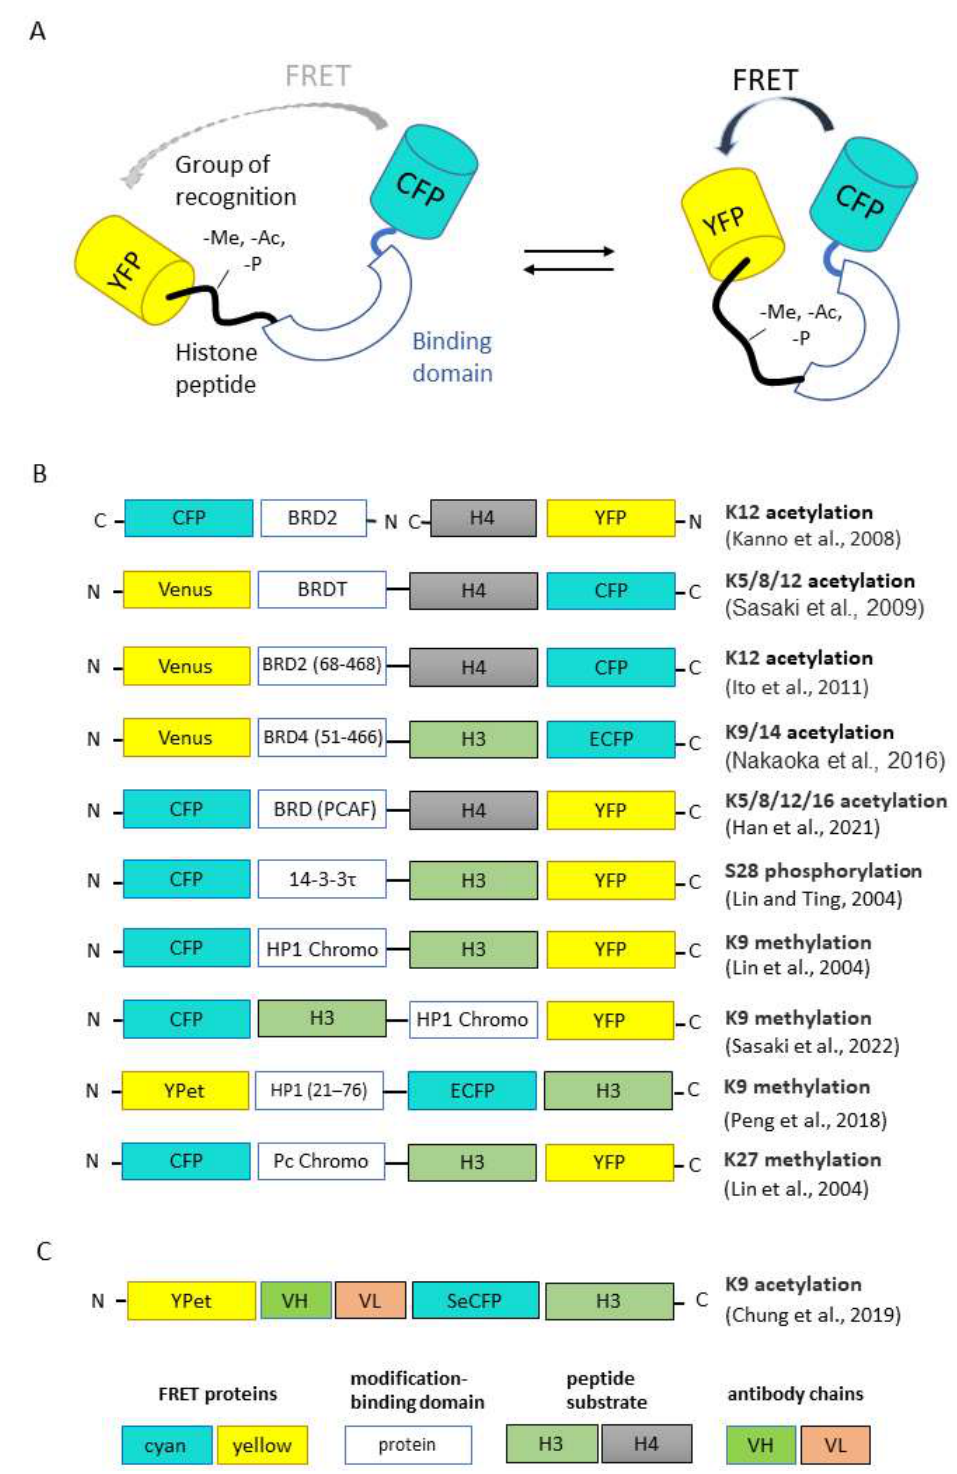
Figure 3. Genetically encoded FRET sensors for live-cell imaging. ( A ) General design of FRET sensors. ( B , C ) Domain structures of FP-based and scFv-based FRET sensors, respectively. Here, and in analogous schemes, below protein parts are not to scale [36–45].